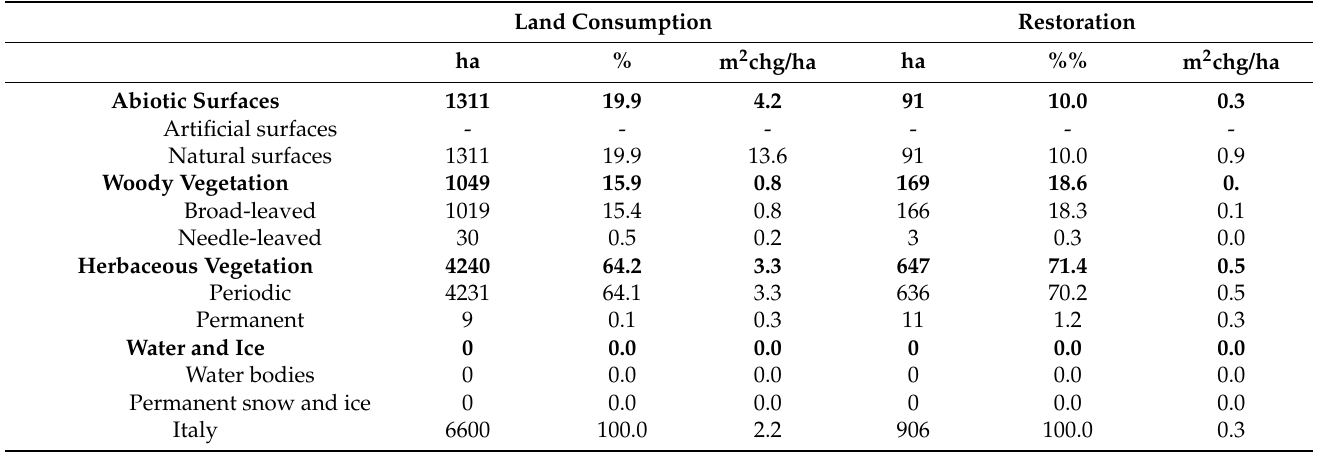
Table 9. Distribution of land consumption between 2017 and 2018 among land cover classes. Land